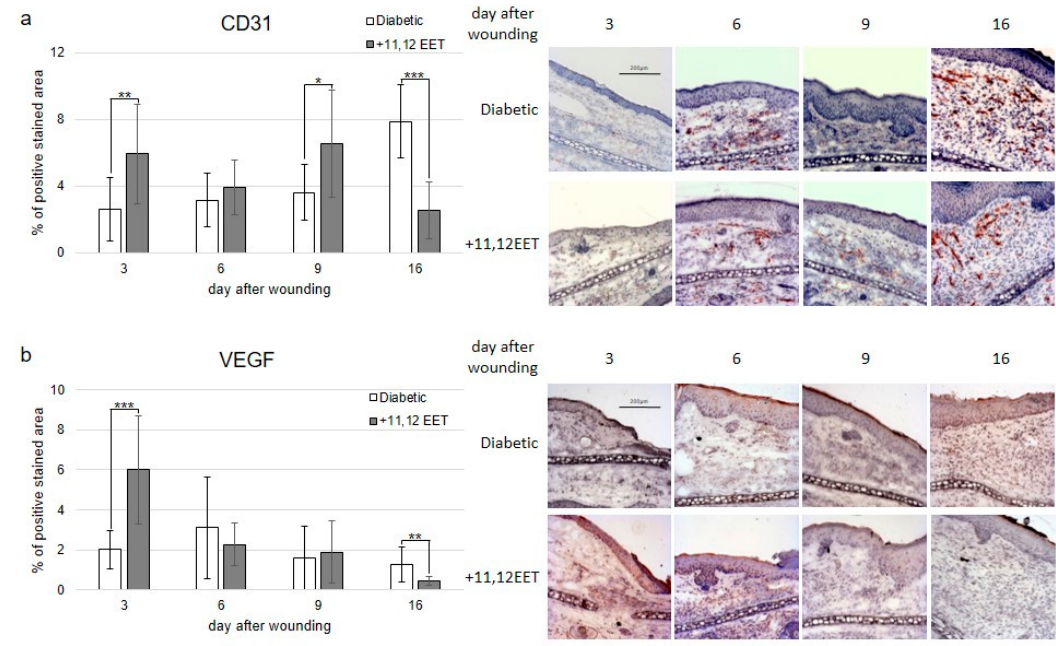
Figure 2. ( a ) Percentage of CD31-positive area on days 3, 6, 9, and 16 after wounding of diabetic mice without and after treatment with 11,12 EET; on the right, representative pictures of the staining. ( b ) Percentage of VEGF-positive cells on days 3, 6, 9, and 16 after wounding of diabetic mice without and after treatment with 11,12 EET; on the right, representative pictures of the staining. (Data are shown as mean ± SD; n = 10 ) * p ≤ 0.05, ** p ≤ 0.01, *** p ≤ 0.001.